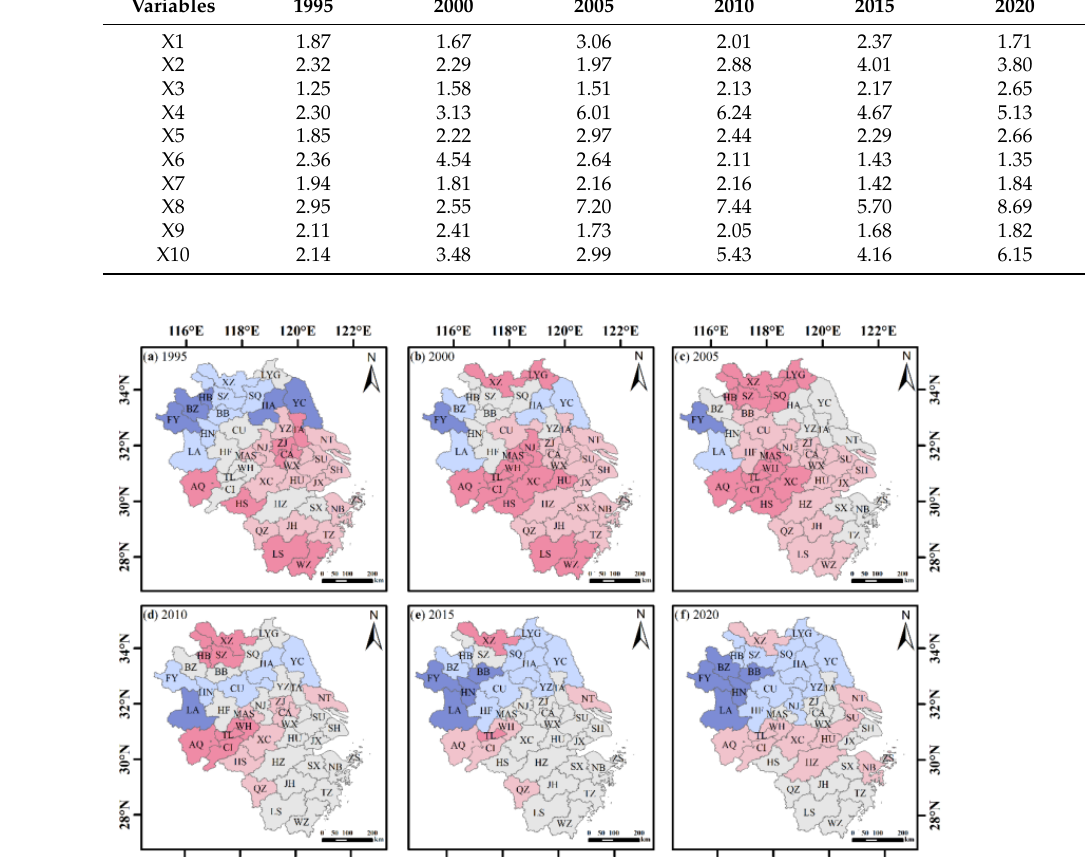
Figure A3. Spatial distribution of the regression coefficients of the total population.